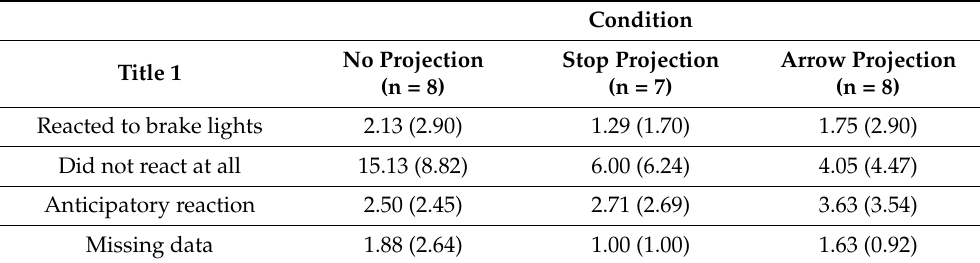
Table 1. Simulator Study Mean, SD, and number of cases by